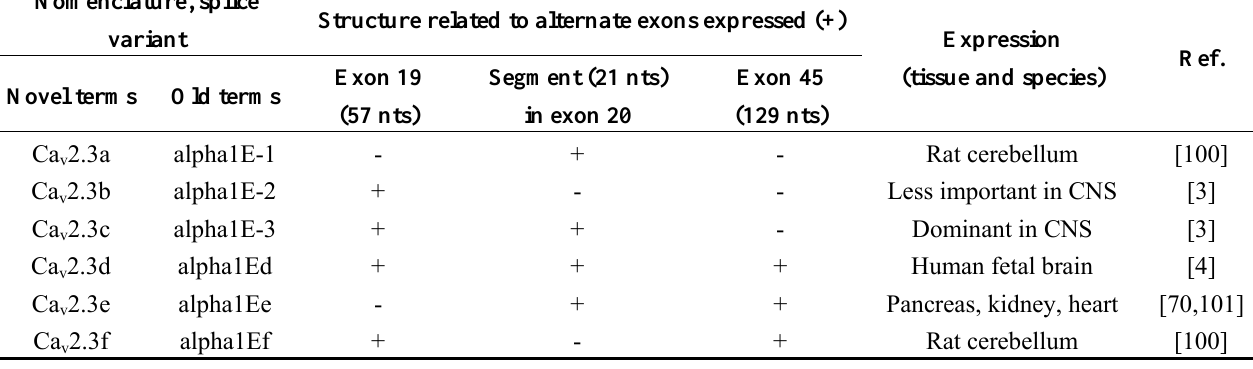
2.3 R-type Ca 2+ channels. Exon 19 is v